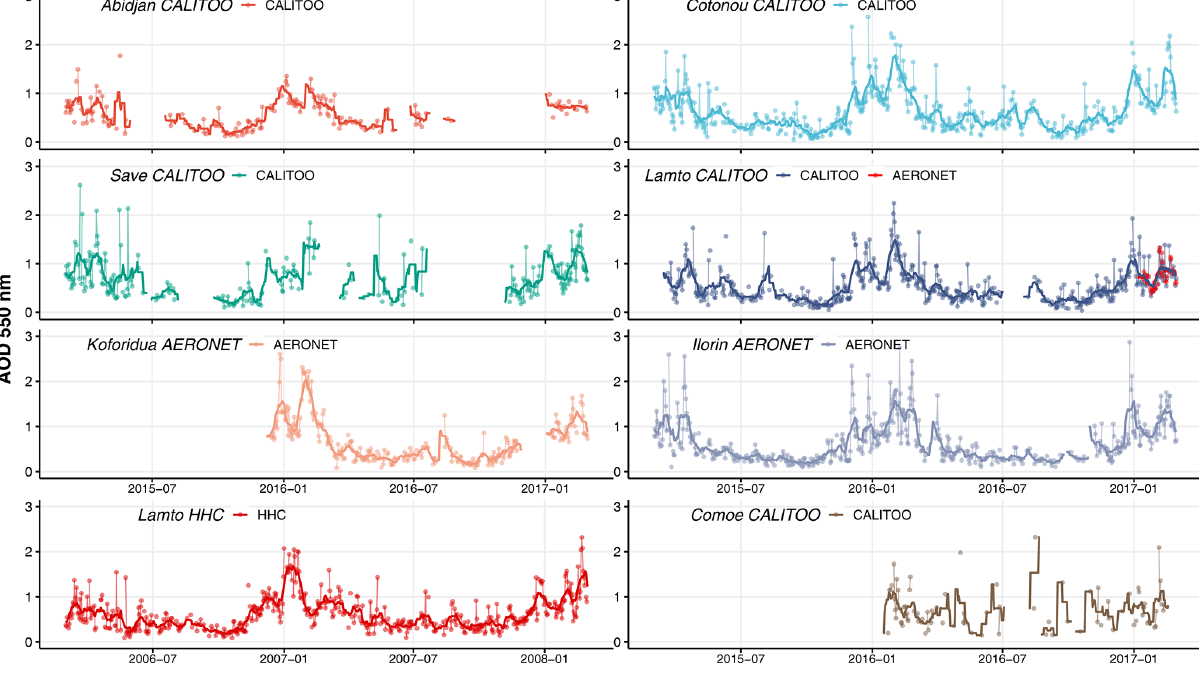
Figure 3. Daily aerosol optical depth at 550nm. The name of the site and the type of instrument used are given in the legend of each plot. The solid line is a 2-week smoothing